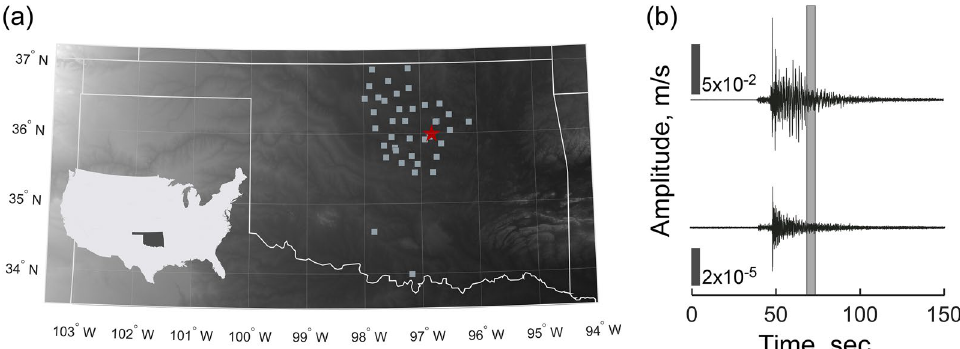
Fig. 1 a Center of the event cluster and station locations. The red star indicates the centroid of the cluster. Squares indicate the location of stations used in this study. The bottom left image indicates the contiguous United States (light gray) and the area of the State of Oklahoma (black). b Example of a waveform from a large event (top) and a small event (bottom). The top waveform represents the event in Table 1b, and the bottom waveform represents the no.1 event in Table 1a. Both were recorded at station OK025. The rectangle in the middle portion of seismograms indicates the window used in the analysis